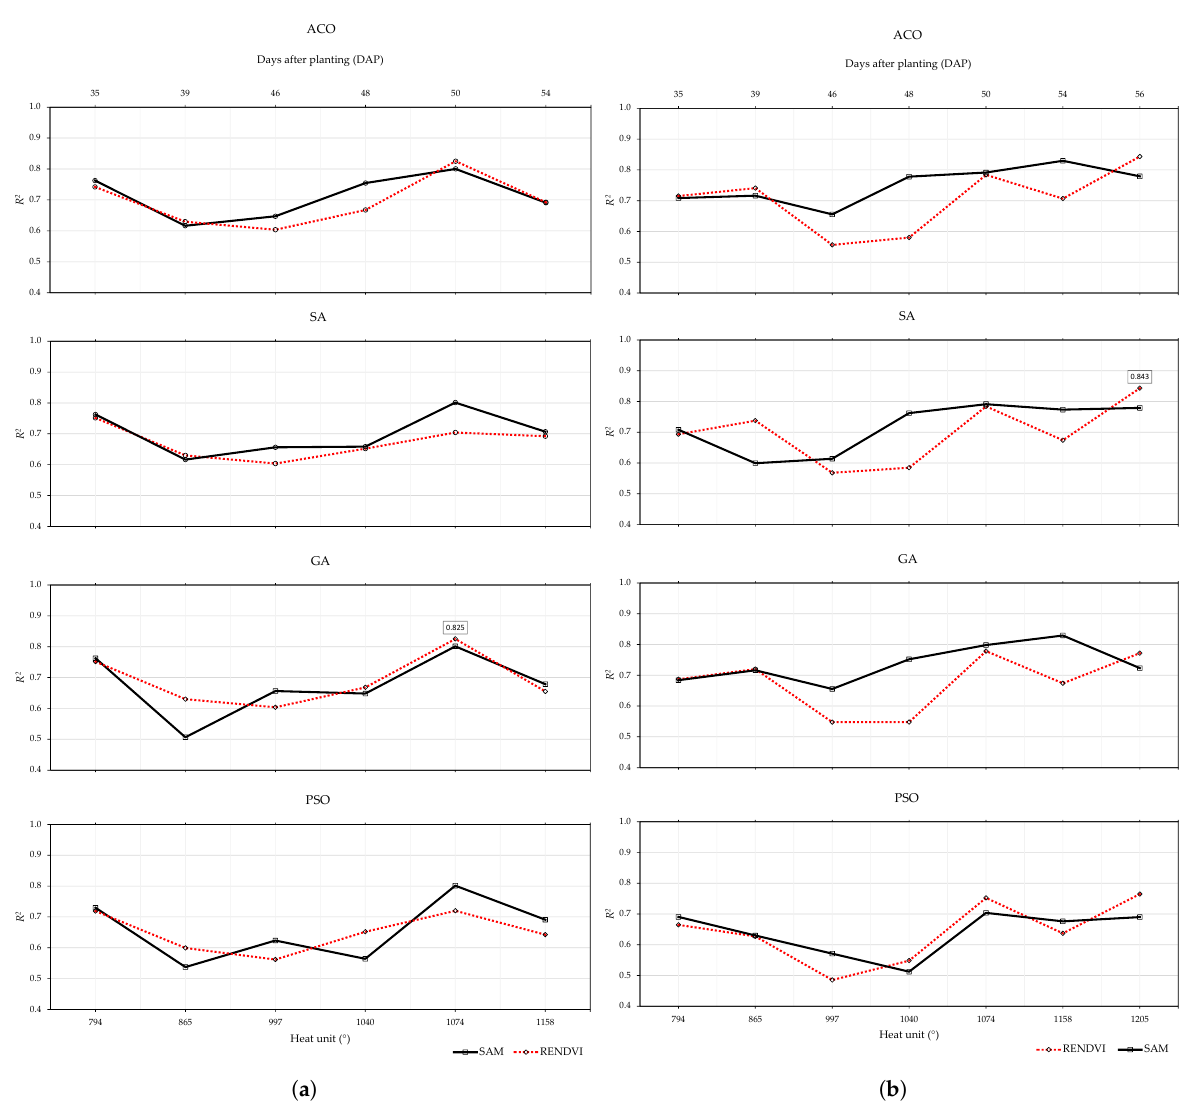
Figure 15. Results for the coefficient or determination ( R 2 ) for snap bean 2019 seed length data set, for ( a ) the early and ( b ) the late harvest stage, via two different vegetation approaches, namely SAM and RENDVI, as tested via